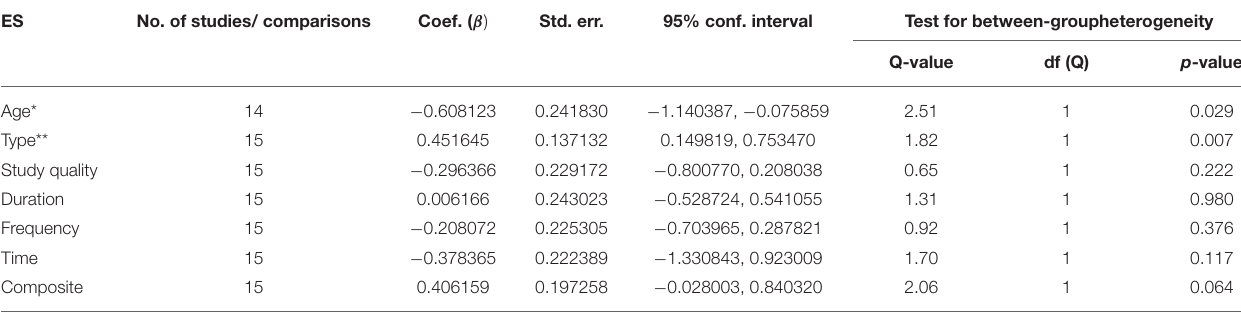
TABLE 7 | Regression analysis for chronic exercises versus the control group of inhibitory control.